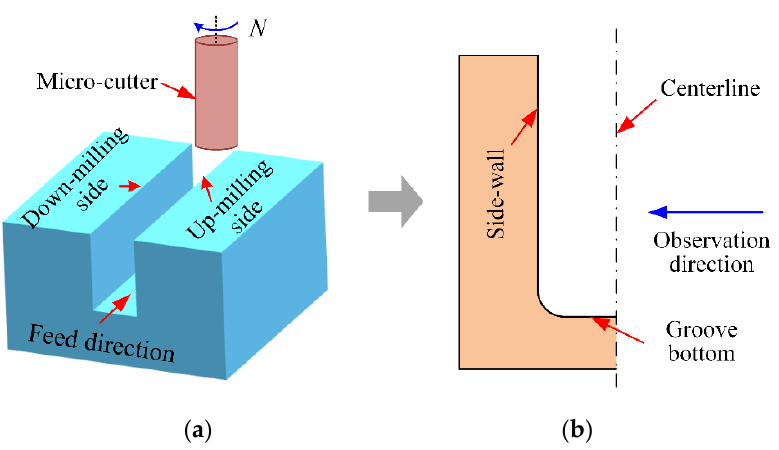
Figure 9. Observation diagram of side-walls. ( a ) HAR micro-groove; ( b ) Observation direction.